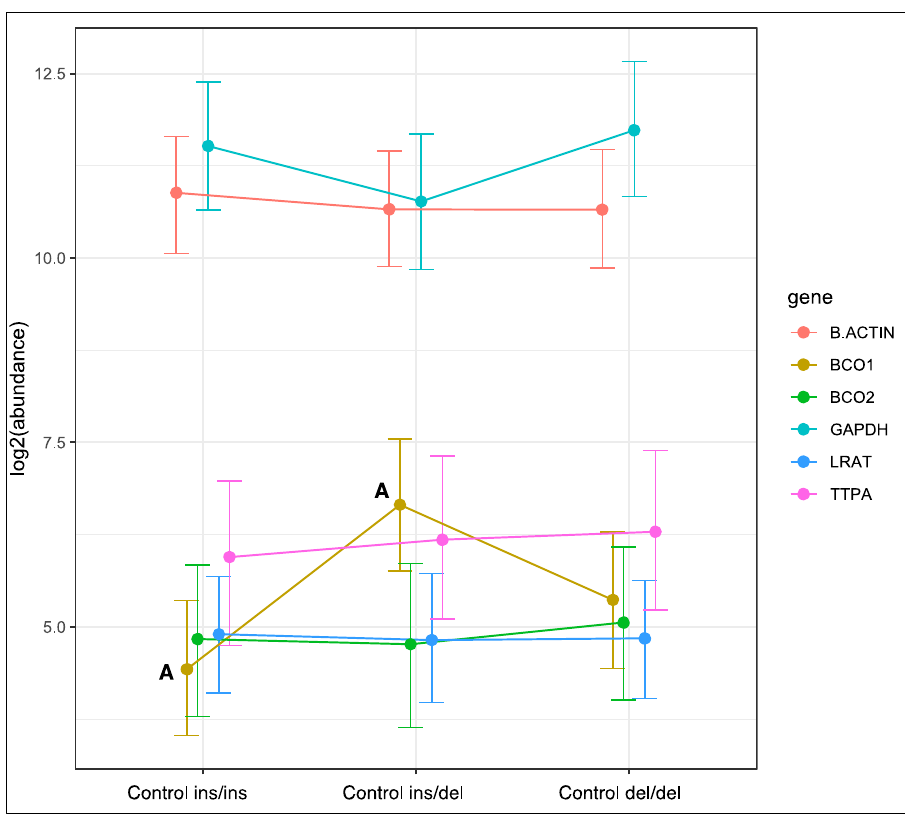
Figure 1. Relative BCO1 , BCO2 , LRAT , and TTPA mRNA levels in the liver of rabbits with different genotypes at codon 248 of the BCO2 gene (ins/ins vs. ins/del vs. del/del) fed the control diet. GAPDH and β -actin were used as reference genes. Data represent posterior means (expressed as arbitrary units) ± 95% credible intervals. Means followed by the same superscripts (A, A) differ highly significantly ( p ≤ 0.01).